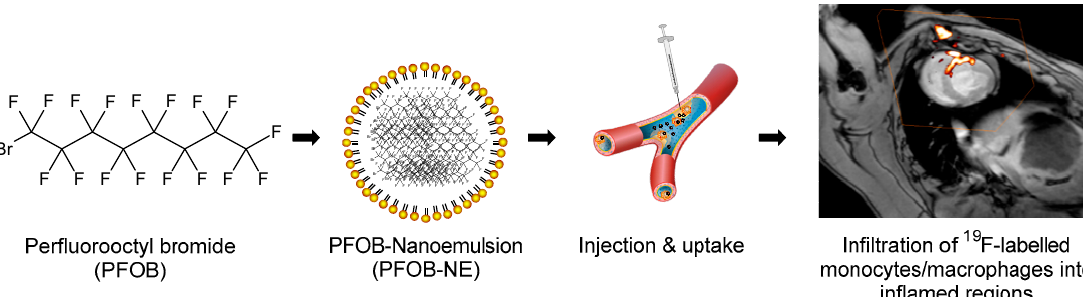
Figure 1. Workflow of perfluorooctyl bromide-nanoemulsions (PFOB-NE) application in pre-clinical animal models (modified from Flögel, et al. [3] and Jacoby, et al. [13]). An example of local inflammation after myocardial infarction as detected by 19 F MRI in a large animal model at clinical field strength (3 Tesla) is shown on the right (Modified and reprinted from [11] with permission from Springer Nature, original copyright 2018).